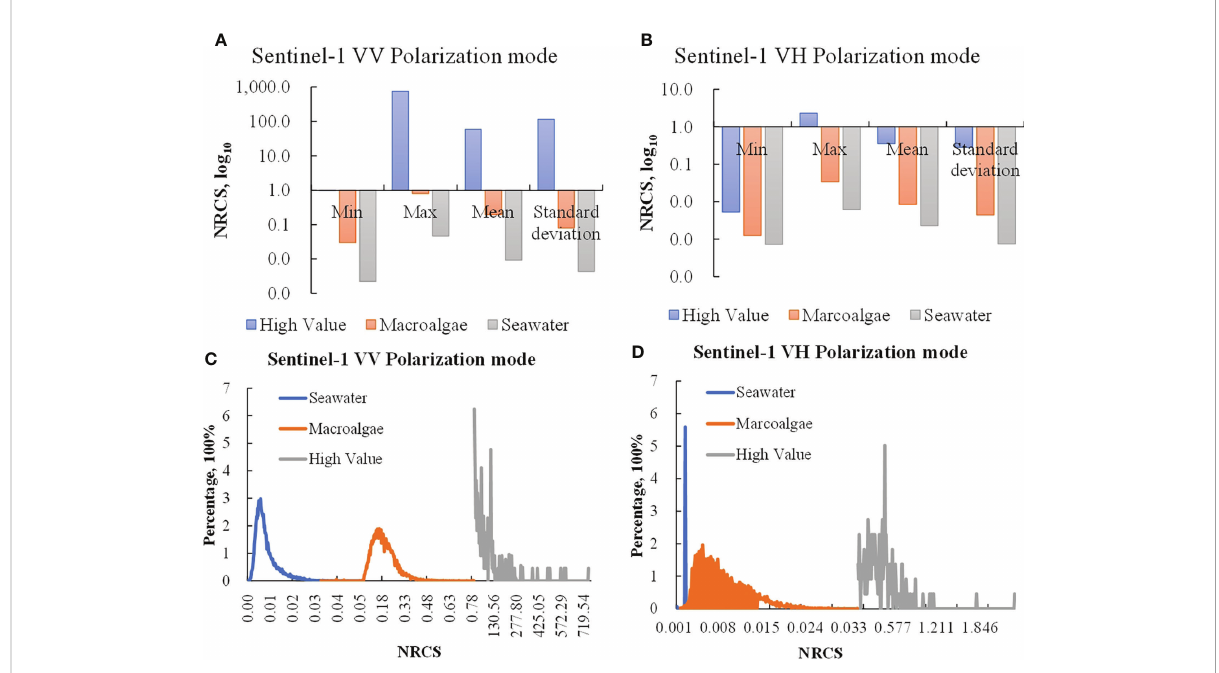
FIGURE 3 The radar backscattering coef fi cient (NRCS) comparison of pure seawater pixels (Seawater), pixels containing macroalgae (Macroalgae) and high NRCS pixels (High Value) in VV and VH polarization mode. (A, B) are the comparison of maximum value (Max), minimum value (Min), mean value (Mean) and standard deviation. (C, D) are the histogram comparison of Seawater, Macroalgae and High